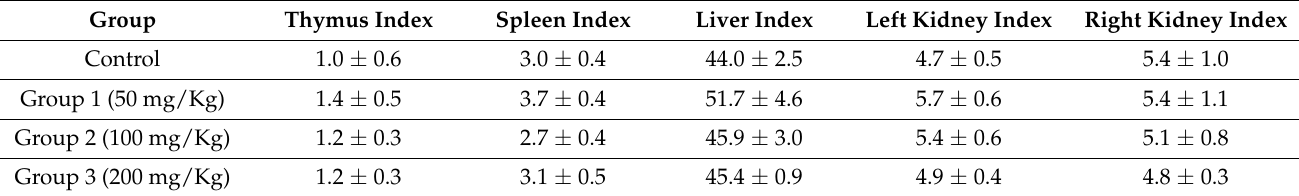
Table 9. Effect of administration of novel nutraceutical in three different concentrations on the organ weight index (mg/g) in mice.